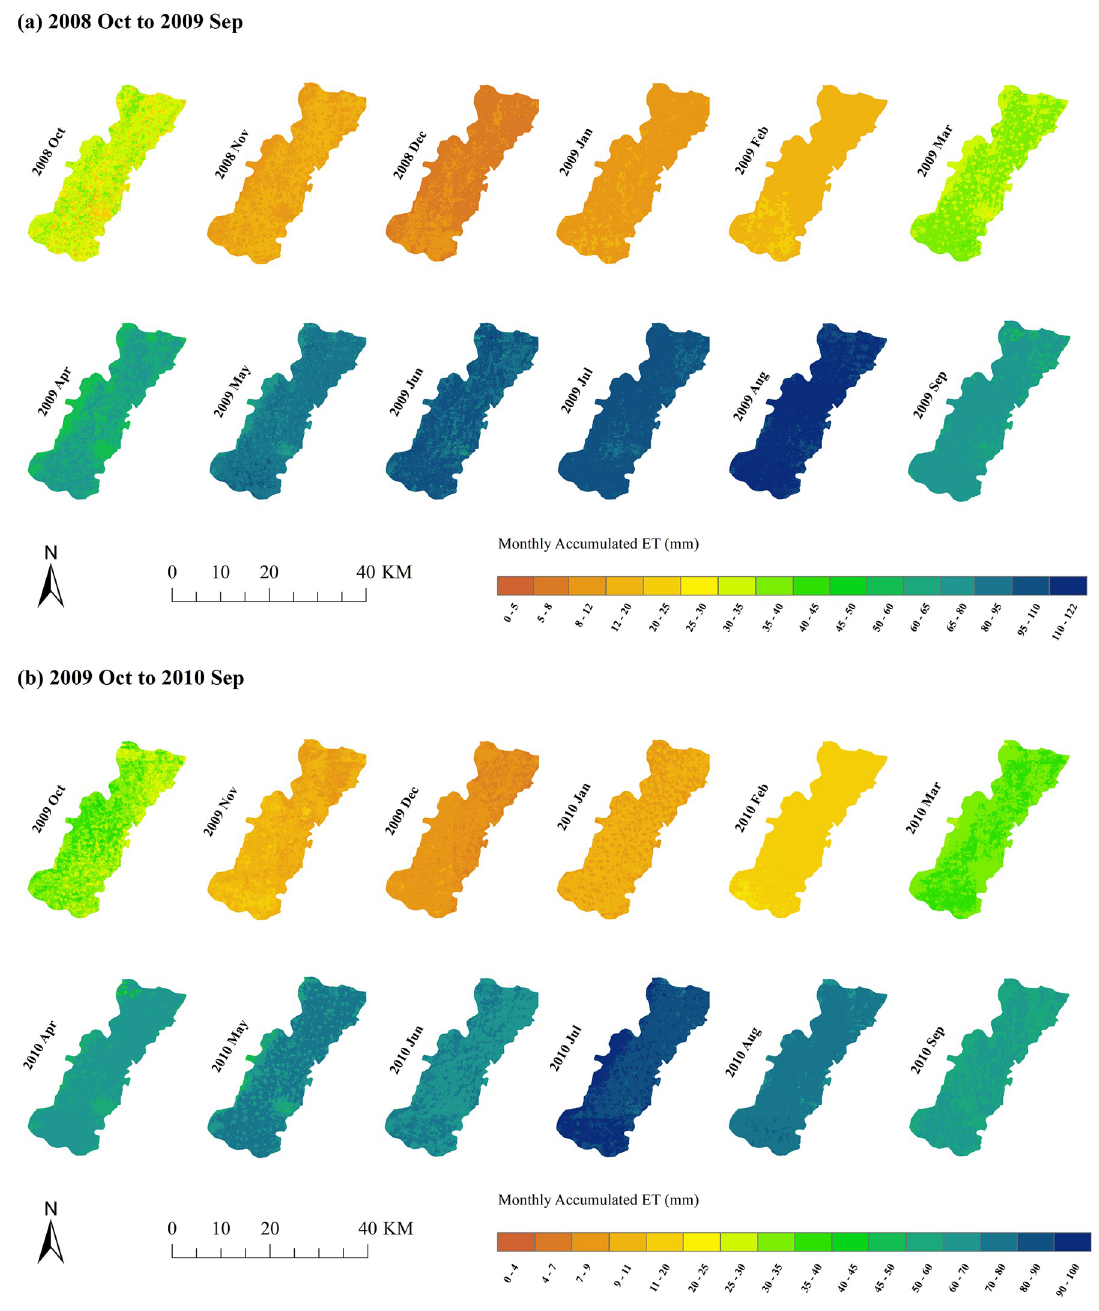
Fig 7. Spatial ET distribution of summer maize and winter